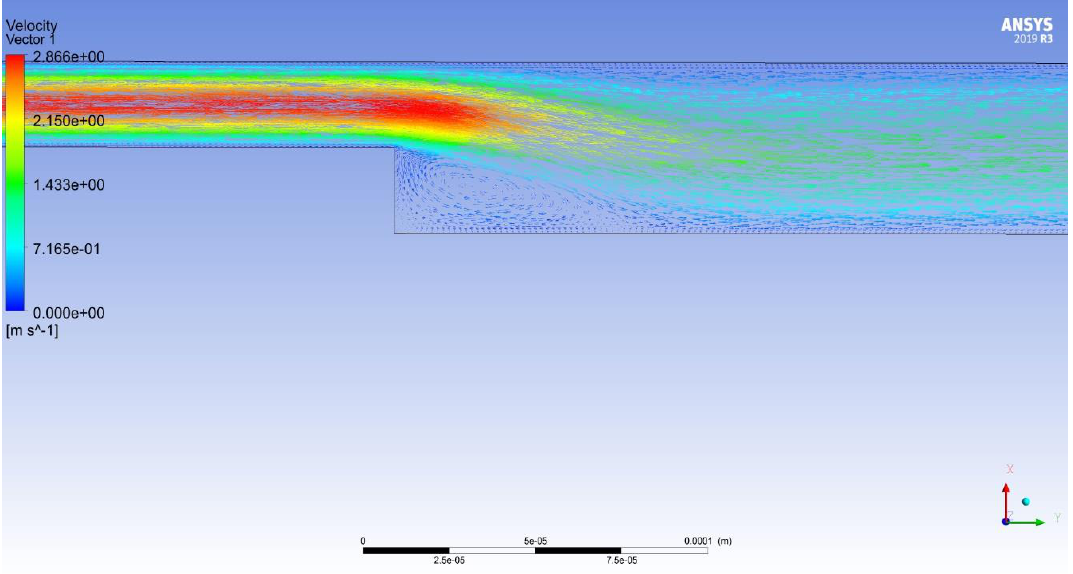
Figure 10. Velocity distribution in the Reynolds Stress turbulence model.